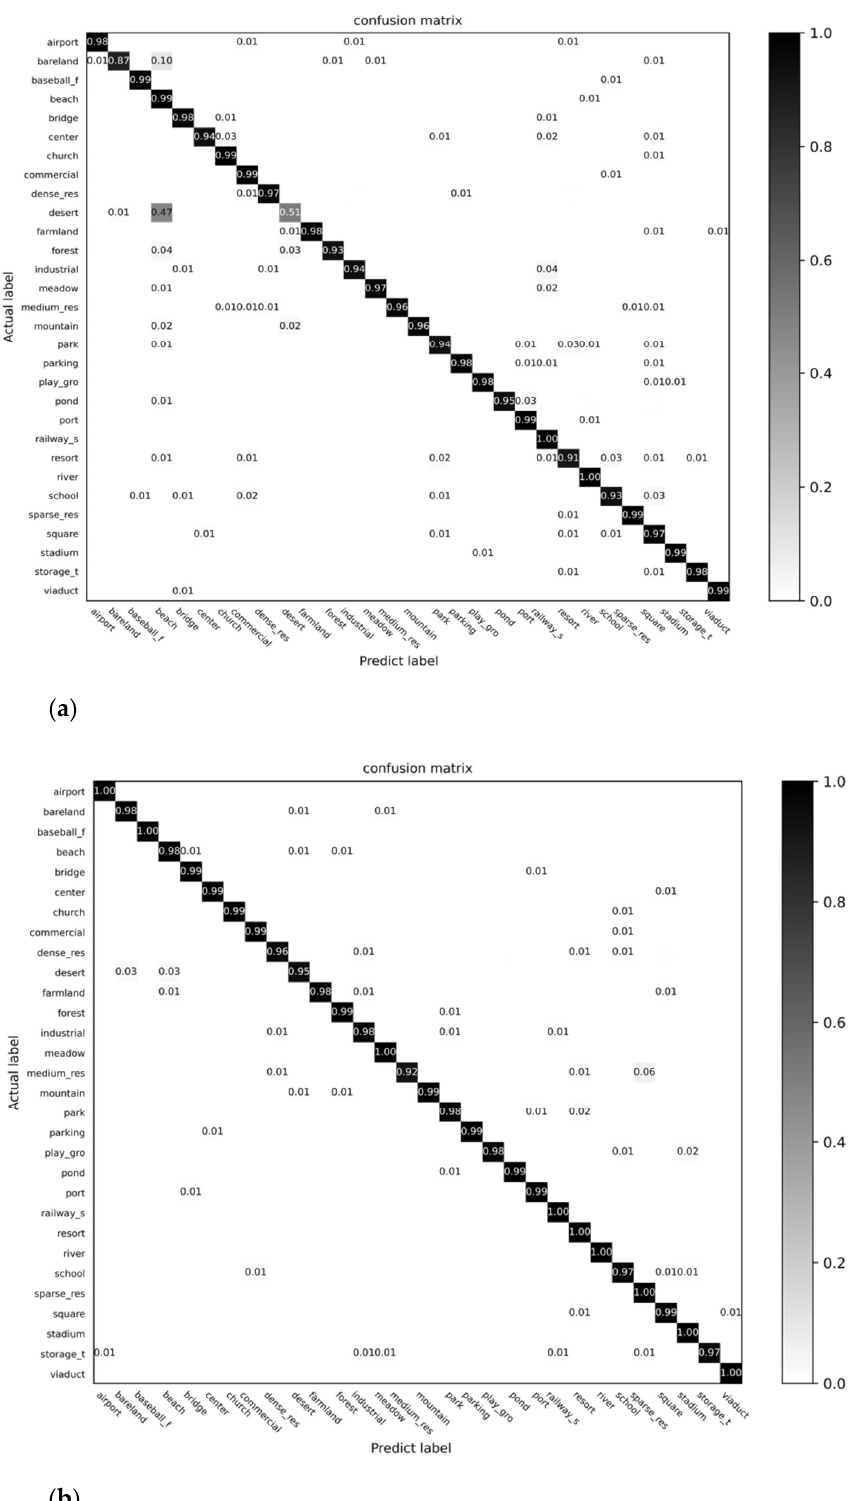
Figure 7. Confusion matrices of the AID dataset. ( a ) Linear evaluation under the 20% training ratio. ( b ) Linear evaluation under the 50% training ratio. NWPU-RESISC45 Dataset: Compared with AID and UC-Merced, NWPU has more remote sensing scenes and is more difficult to train. The experimental results are shown in Table 5. At 10% NWPU training ratios, TRS achieves 93.06 ± 0.11% accuracy, which is